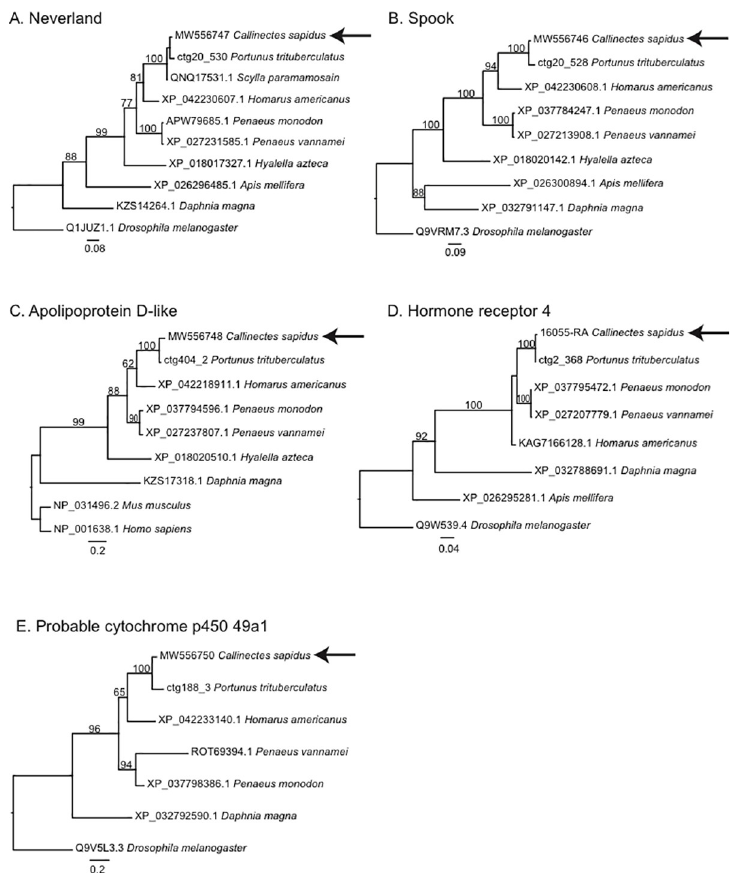
Fig 3. Phylogenic trees were generated using the default settings of Phylogeney.fr (http://www.phylogeny.fr/ simple_phylogeny.cgi). Sequences were aligned using MUSCLE, trimmed with GBLOCKS, and trees were built with PhyML. The sequencing data is included in fasta format as supplemental files (S1–S5 Files). The C . sapidus sequences are noted with an arrow in A. Neverland (Accession No MW556747);B. Spook (Accession No MW556746);C. Apolipoprotein D-like (Accession No MW556748);D. Hormone receptor 4 (Accession No MW556749);and E. Probable cytochrome p450 49a1 (Accession No MW556750). Scale bars present fixed mutations per amino acid position. And, bootstrap values (%) supporting nodes are noted with